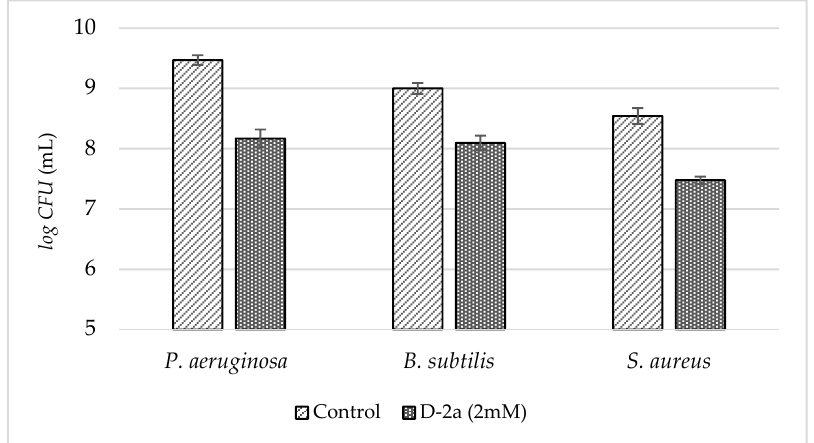
Figure 10. Bacterial density expressed as log CFU/mL of S. aureus , B. subtilis, and P. aeruginosa after 24 h of incubation without (control) and 2 mM of compound D - 2a . Each column and bar represent the mean and the standard deviation, respectively ( n = 2). CFU, colony-forming unit.